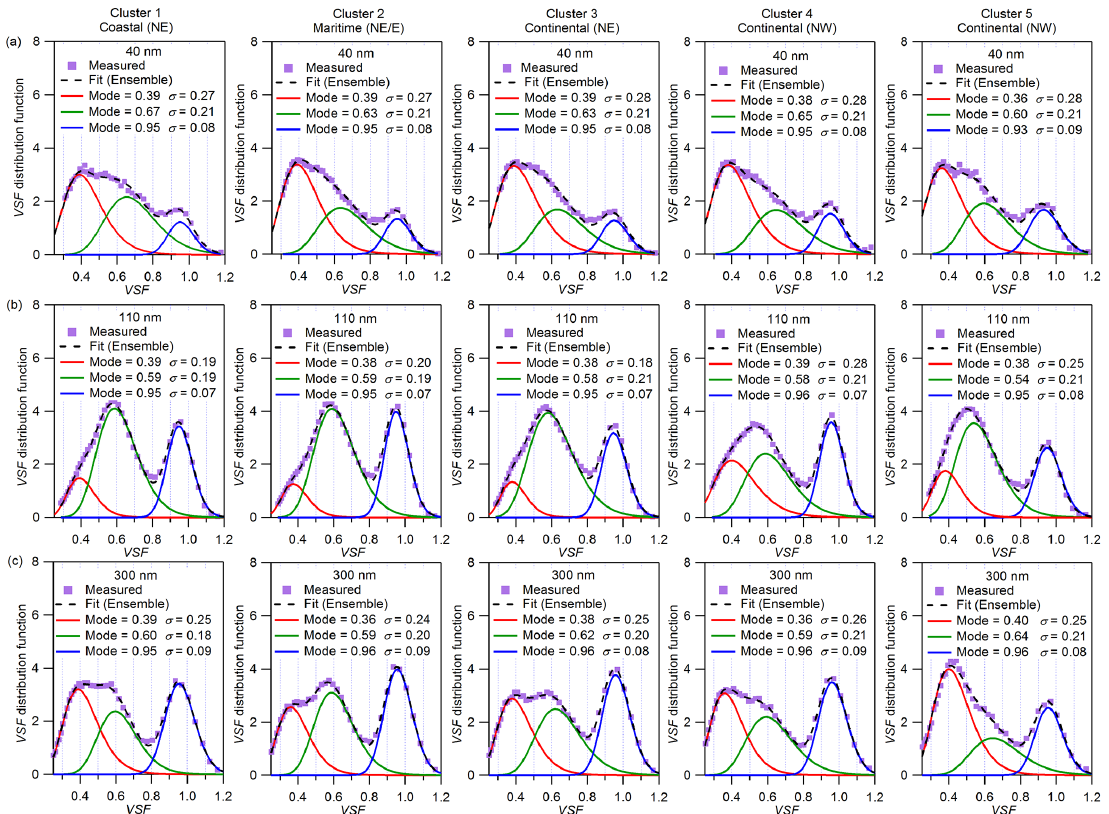
Figure 9. Volatility shrink factor (VSF) distribution function in different clusters. Solid and dotted lines are the peaks fitted with log-normal function and the ensemble distributions, respectively.